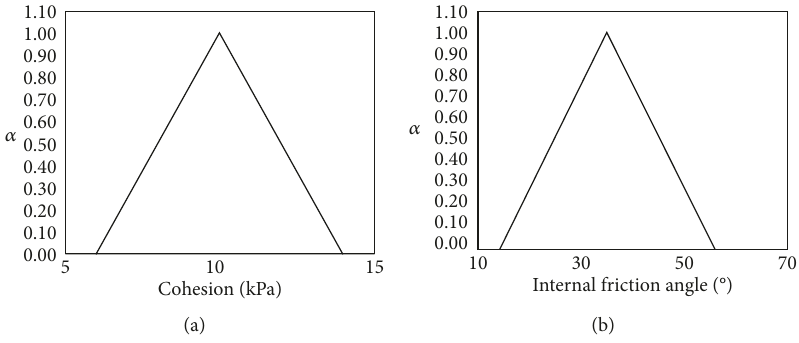
Figure 5: Fuzzy number of (a) cohesion and (b) friction angle of loam soil.